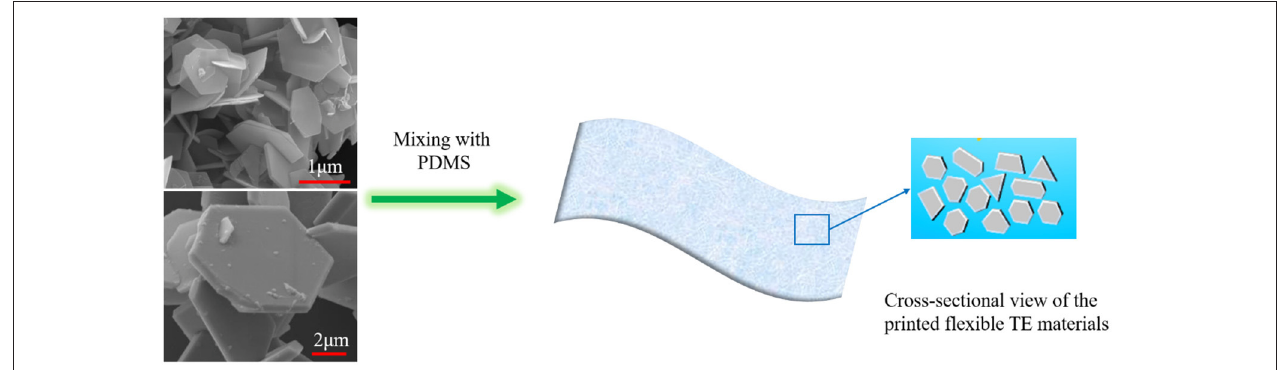
FIGURE 1 | Schematic of the fabrication of printed flexible TE materials. SEM images were from our previous work (Fangfang et al., 2019).